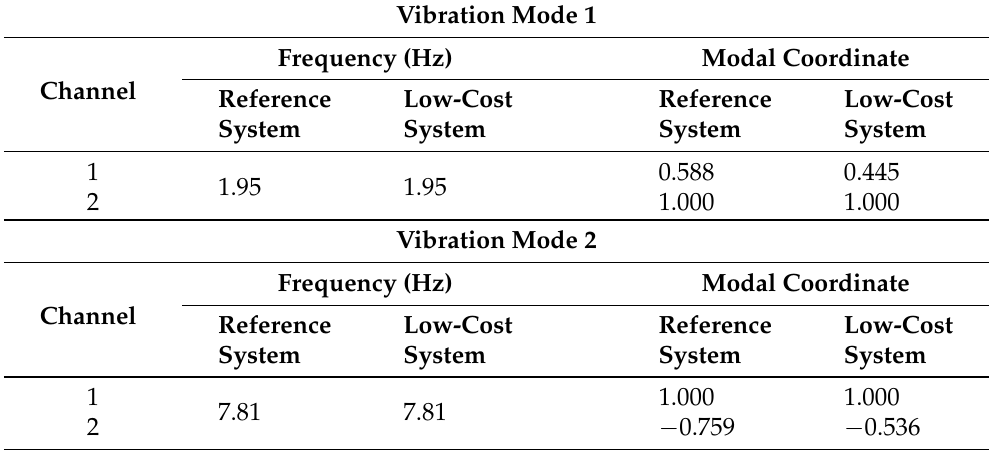
Figure 19. Dynamic response of the 2-DOF structure in the frequency domain: ( a ) SVD spectrum of the reference SHM system. ( b ) SVD spectrum of the low-cost SHM system. Table 7. Natural frequencies and mode shapes identified of the flexible structure from both monitoring